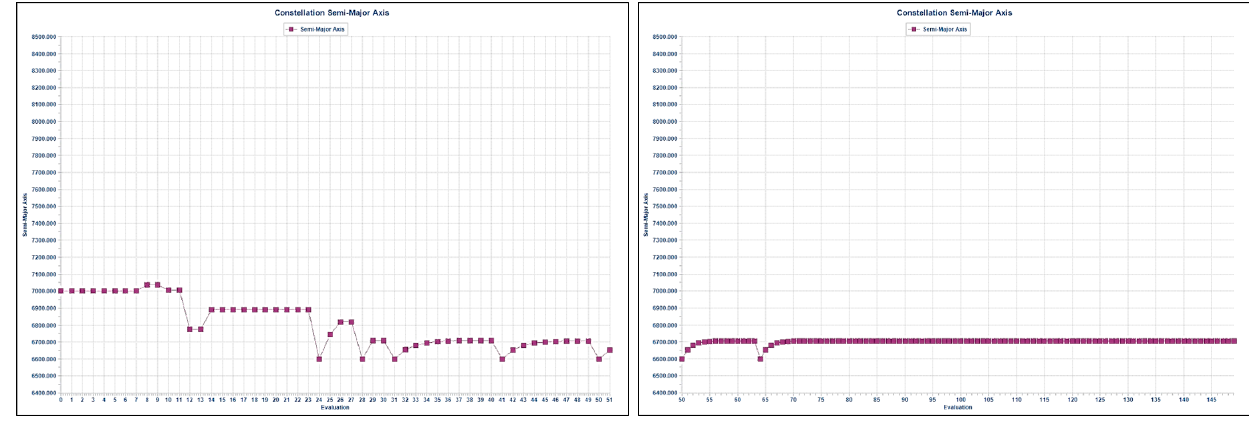
Figure 17. Semi-major axis optimization process for the first 50 and concluding iterations.